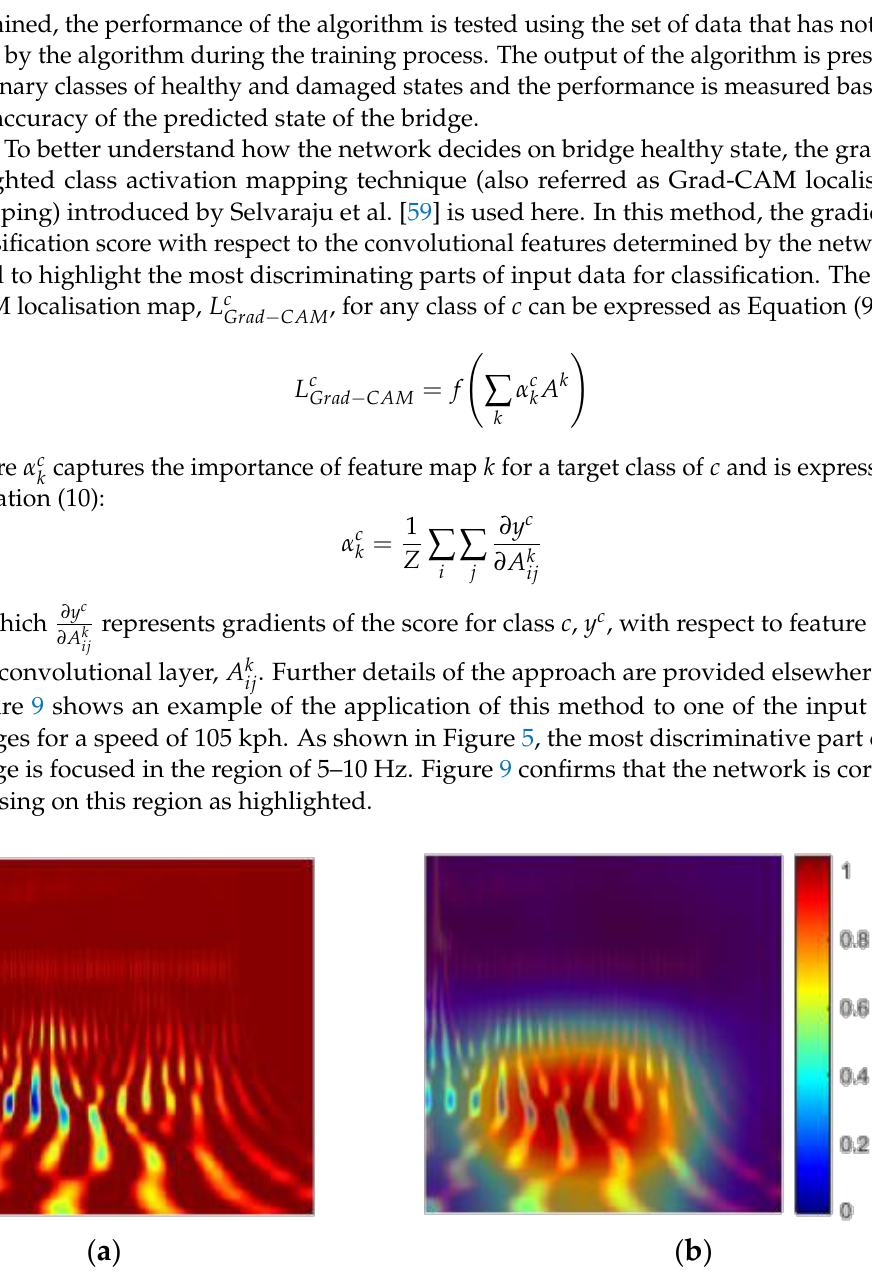
( c ) Figure 10. An example of discriminating cues from CWT images: ( a ) original image; ( b ) activating features in max pool layer 3 × 3; ( c ) activating features in inception (5b). To further demonstrate the power of activations in the trained CNN, the t-distributed stochastic neighbour embedding method (t-SNE) [60] is used. This method is often em- ployed to present high-dimensional data in a 2D/3D representation. In simple steps, the t- SNE function generally calculates pairwise distances between high-dimensional points, creates a standard deviation for each point, calculates a similarity matrix with the corre- sponding joint probability distribution and then creates an initial set of low-dimensional points. This process is iteratively repeated to update the low-dimensional points with the objective of minimizing the Kullback – Leibler divergence between a Gaussian distribution in high-dimensional space and a t-distribution in the low-dimensional space [60]. Figure 11 demonstrates the change in clustering power of the algorithm from the first pooling layer to the final convolution layer and softmax layer using the t-SNE in 2D space. In this representation, the nearby points in 2D space correspond to nearby points in high- dimensional space. Figure 11 shows that while the early layers focus on shallow features, deeper layers detect more complex features by combining features from earlier layers, hence are stronger classifiers. As shown in Figure 4, low-level features in input data do